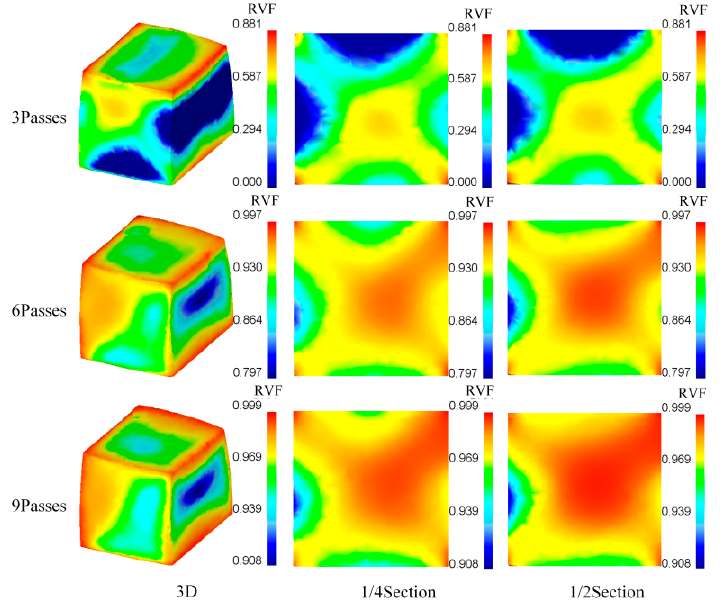
Figure 15. Forging from three to nine passes for recrystallized grain size cloud image at 900 °C.